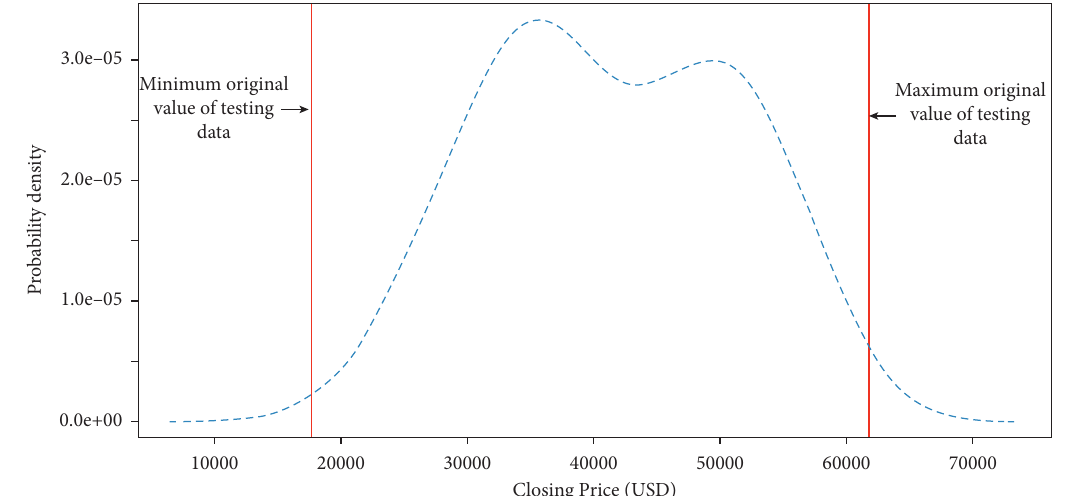
Figure 14: Probability density curve based on SVR-TI-rVMF